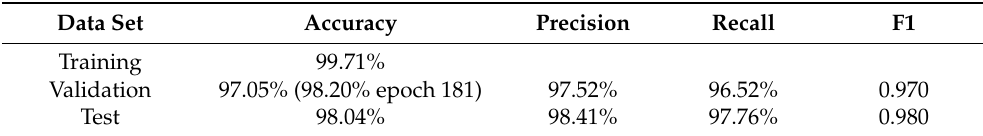
Table 4. InceptionV3 classification Metrics, all layers trainable for 200 epochs.